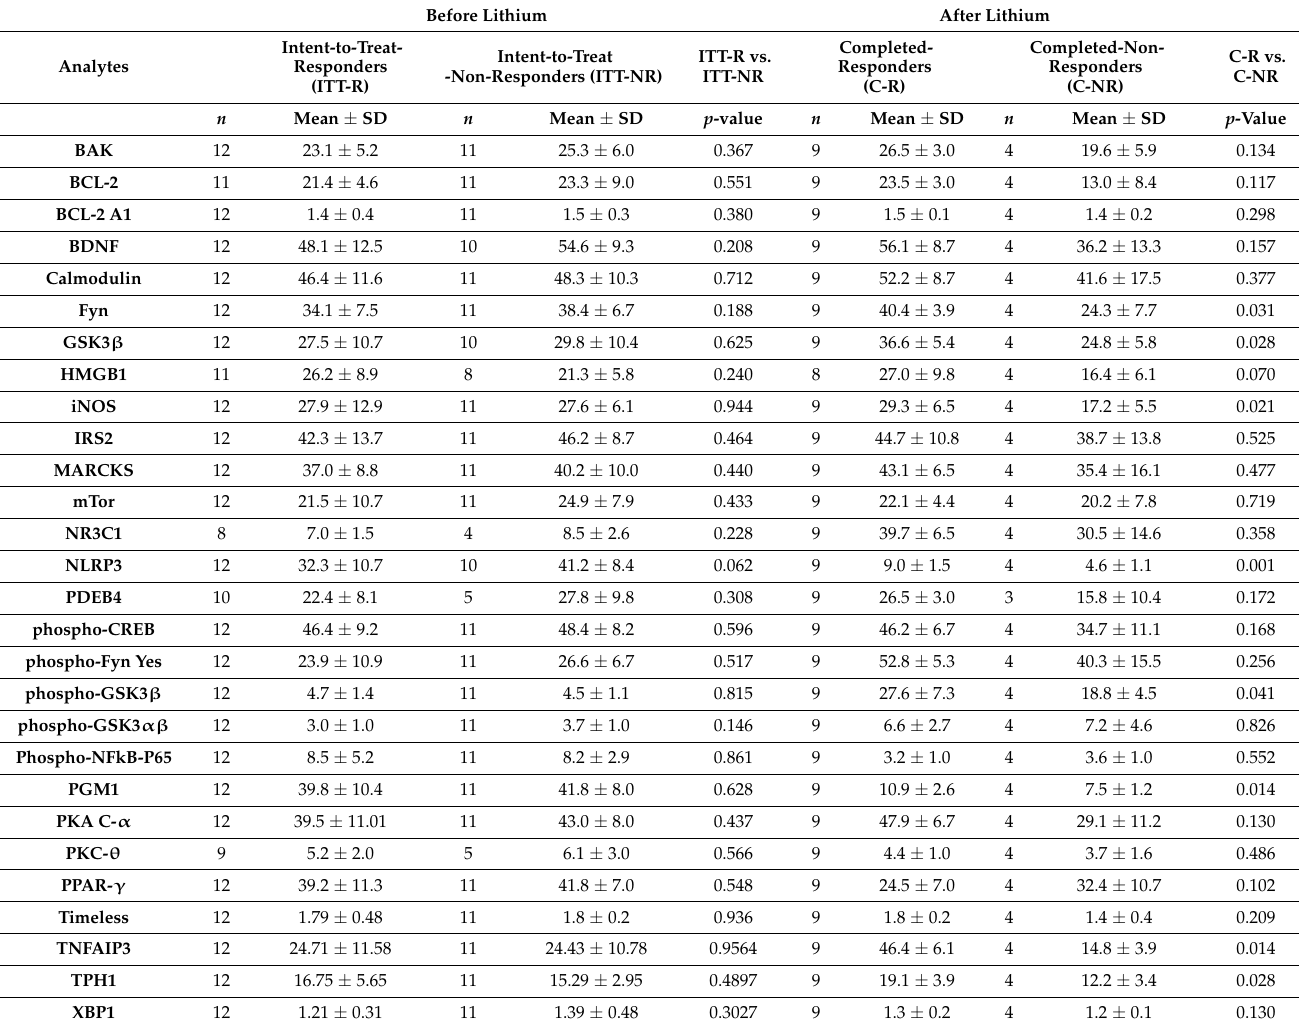
Table 1. Comparison of protein levels in monocytes between lithium responders and non-responders before and lithium